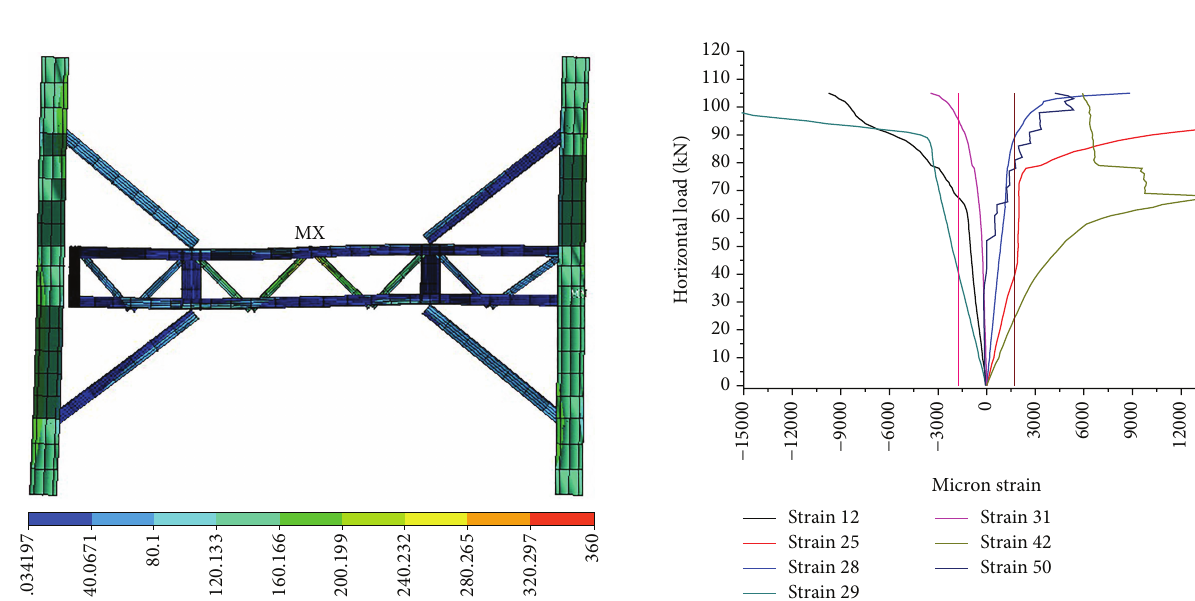
Figure 18: Stress when horizontal load is 24 kN.